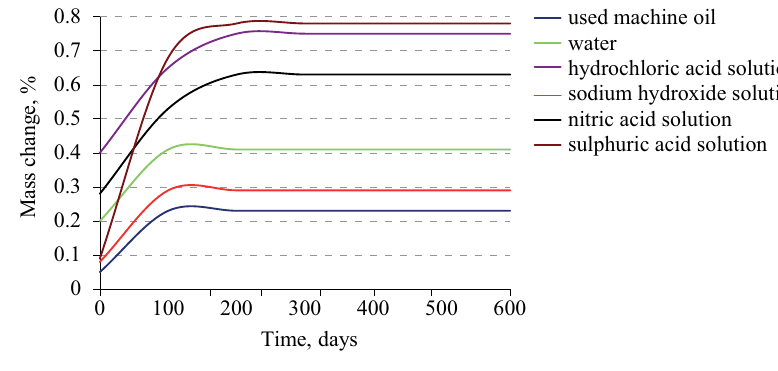
Figure 1. The mass change of the acryl composition samples under the aggressive medium